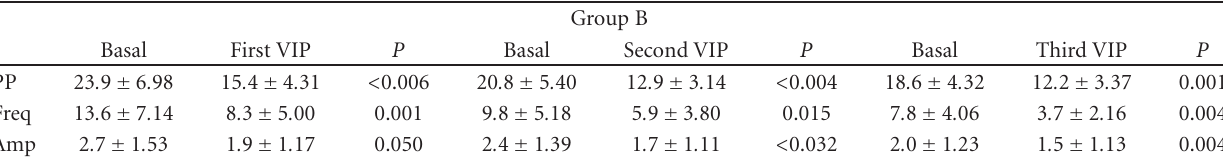
Table 2: PP: Perfusion Pressure (mmHg); Freq: Frequency of oscillations (number oscillations/min); Ampl: Amplitude of oscillations (mmHg); VIP: Vasointestinal Peptide.